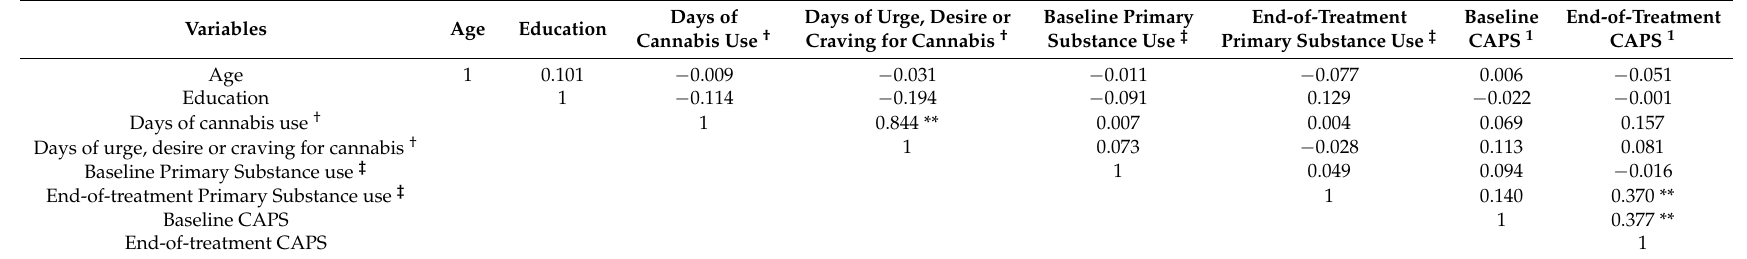
Table 2. Correlations between study